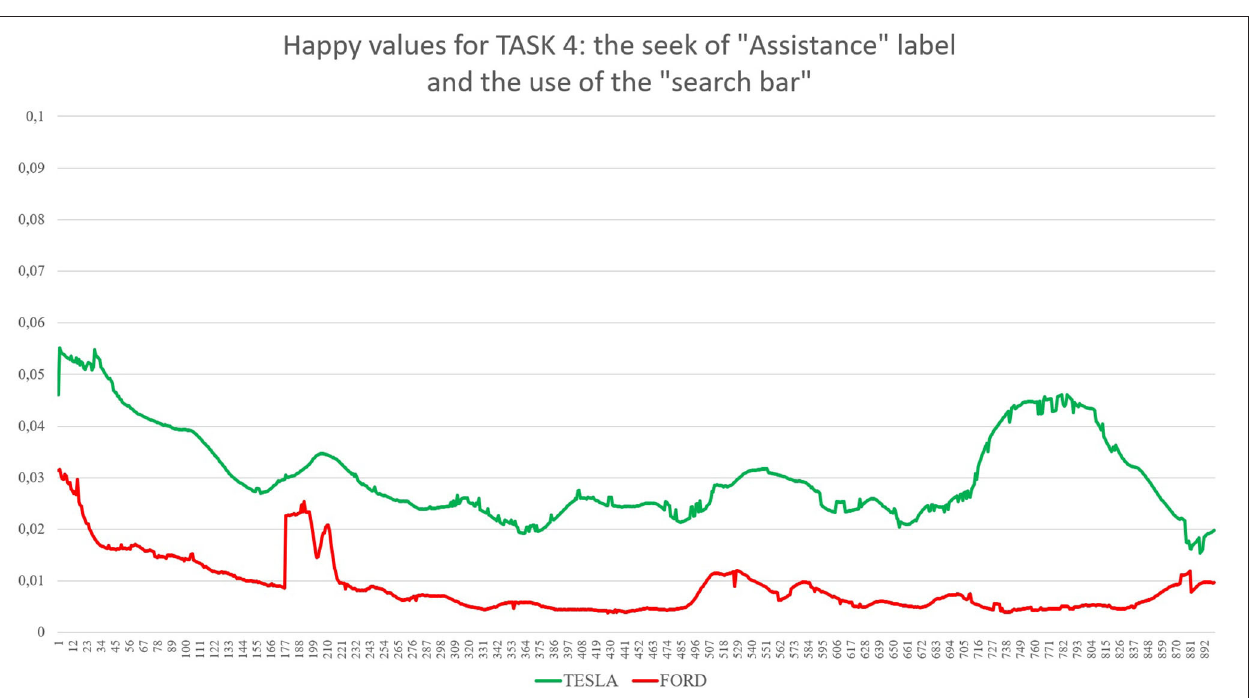
FIGURE 4 | The graph shows values for Happiness for both Tesla and Ford during Task 3 (subjects were asked to use the customising tool). On the X axis, time is expressed in 30 samples per second for a total of 900 samples, corresponding to 30s as total maximum amount of time exposure to the websites for this task. On the Y axis, values of happiness are expressed between 0 (no happiness expressed by the face) and 1 (highest intensity of happiness expressed by the face).